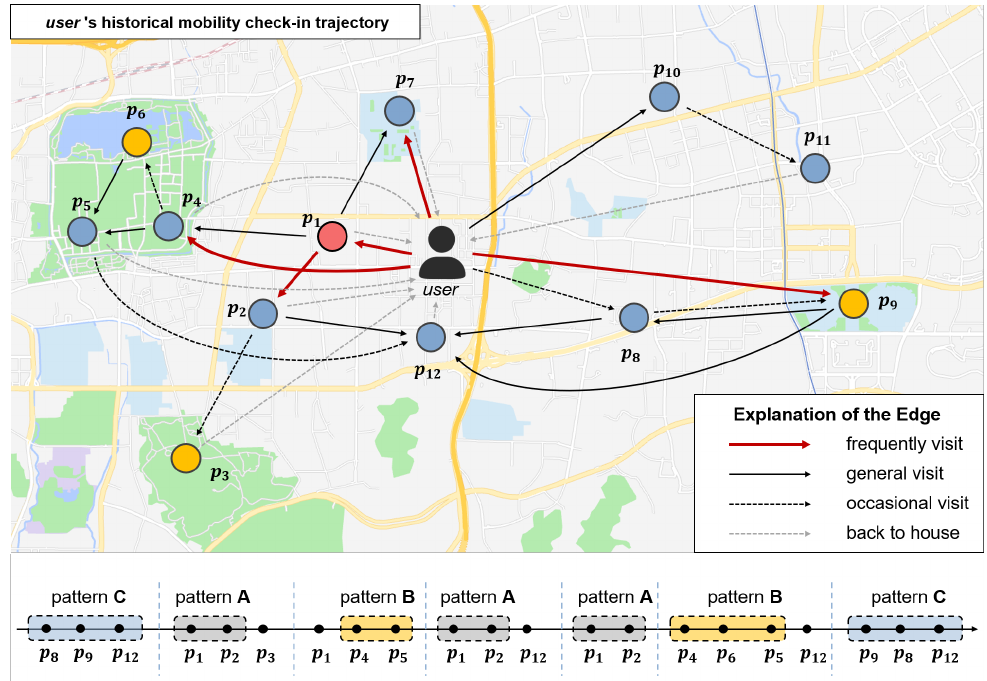
Figure 1. An example showing the implicit behavior patterns of users in complex spatial-temporal transition trajectories. The map illustrating the user ’s historical movement trajectory. The vis- ited locations are named from p 1 to p 12 . The nodes in blue, red, and yellow represent shopping malls/restaurants/supermarkets, workplaces, and leisure venues/attractions, respectively. Below shows the user ’s visit trajectory for a single week, in which the gray, yellow, and blue areas are the user ’s implicit behavior patterns A, B, and C,